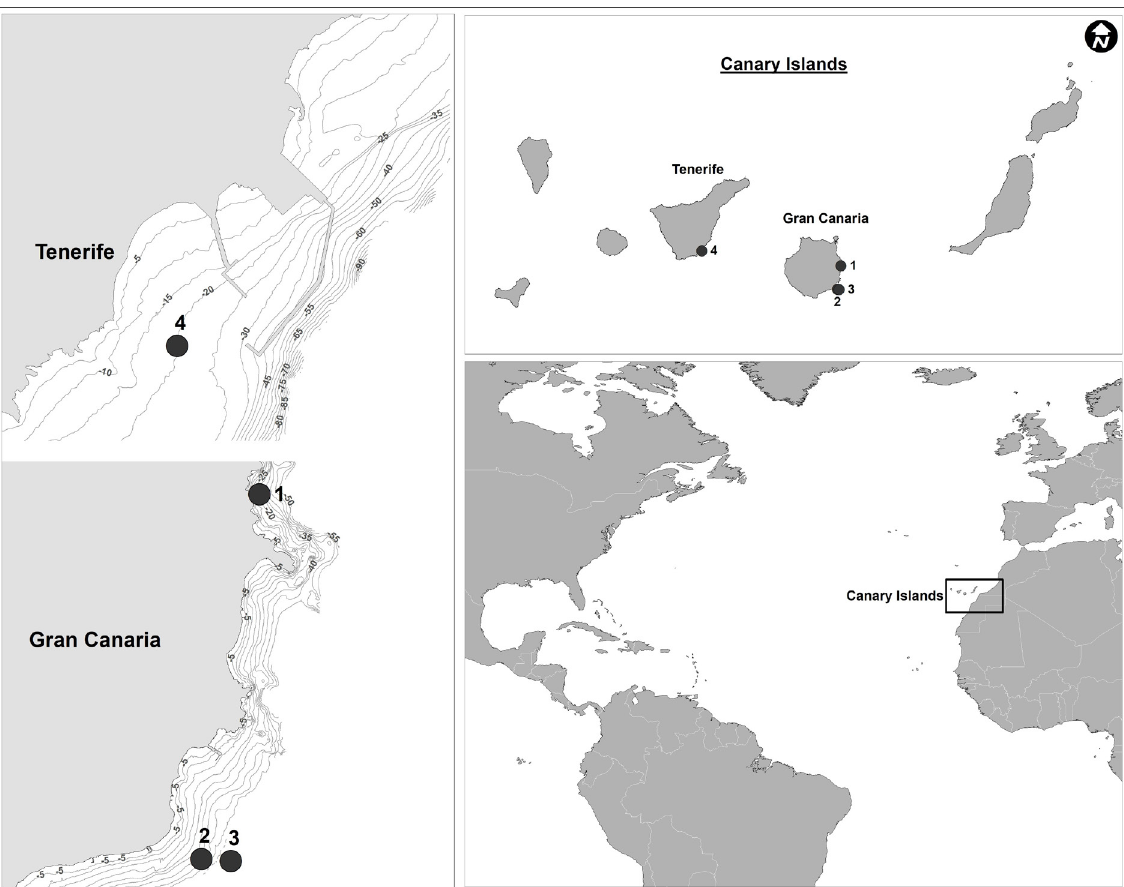
Fig. 1. Map of the Canary Islands with type localities. Gran Canaria: 1 . East coast, off Tufía (holotype, TFMCBM-AN/246). 2–3 . South coast, off Castillo del Romeral (paratypes, TFMCBM-AN/247 and AN/248). Tenerife: 4 . South coast, off Granadilla (paratype, SMF